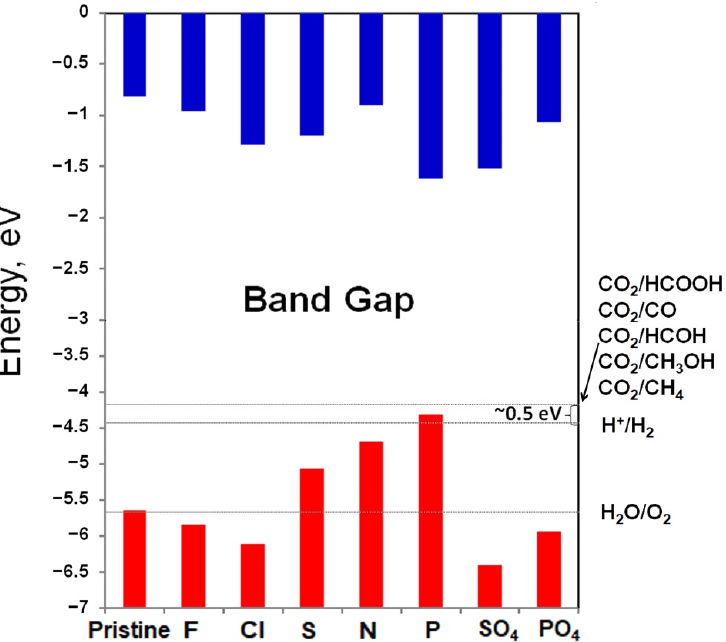
Figure 5. The absolute band alignment of various 2D Mg(OH) 2 calculated by HSE06. The vacuum level is set as zero energy. Blue and red colors stand for conduction band and valence band, re ‐ spectively.